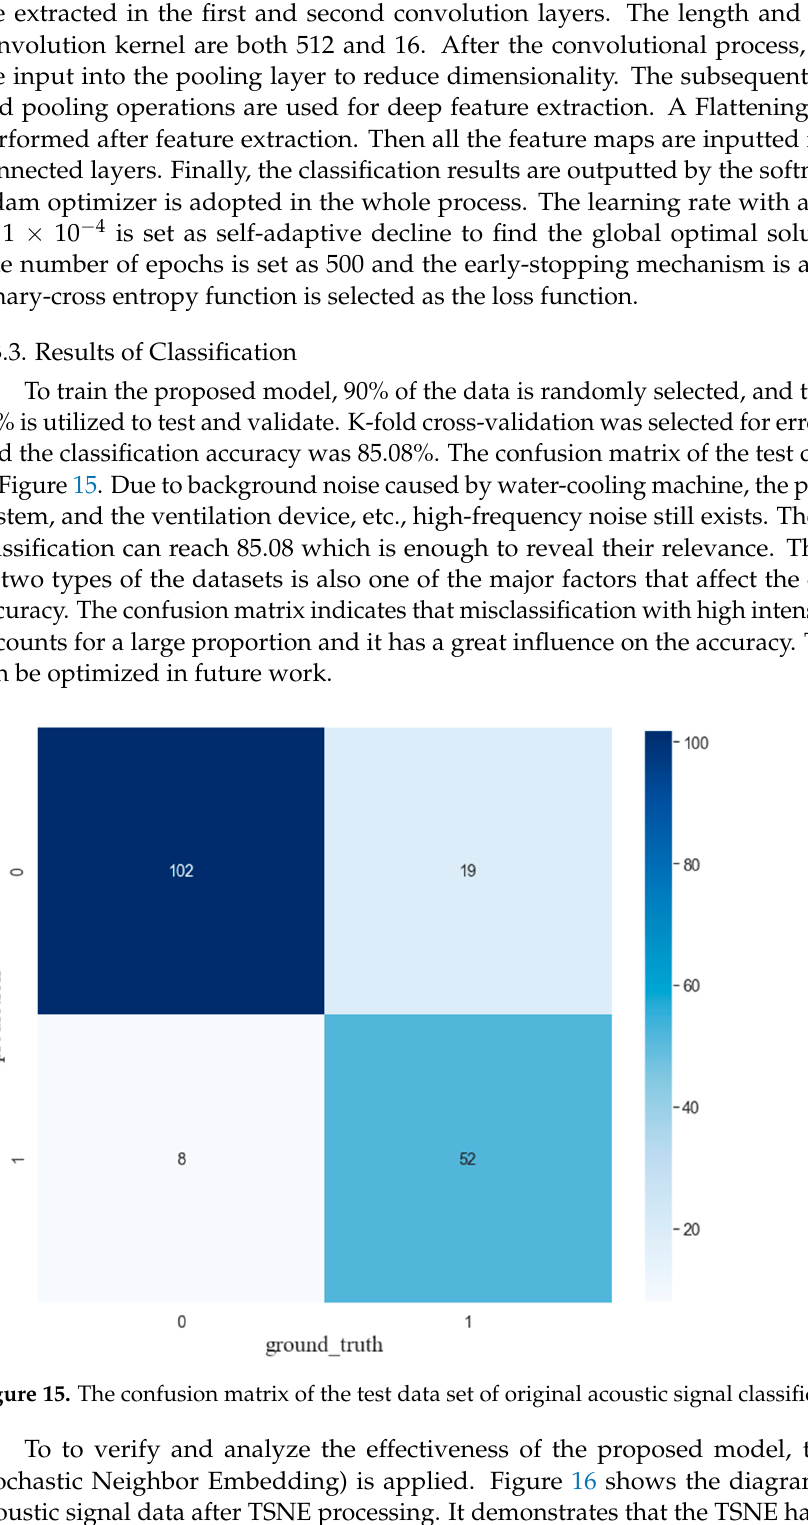
Figure 16. The diagram of the collected acoustic signal data after TSNE processing.